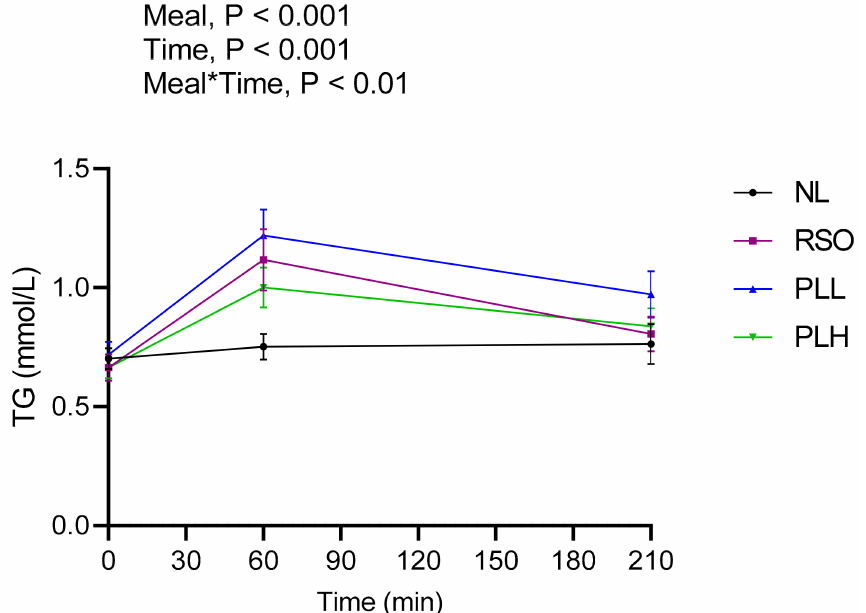
Figure 4. Concentration of serum triglycerides (TGs) after the breakfast meal. Values are means ± SEM, n = 20 healthy subjects. Repeated measures; mixed model in SAS. NL, oat preparation without added lipids; RSO, oat preparation added with rapeseed oil; PLL, oat preparation with a low concentration of polar lipids; PLH, oat preparation with a high concentration of polar lipids. Table 4. TG and FFA responses after breakfast (0–210 min) and a subsequent standardized lunch (210–330 min) 1 . Test